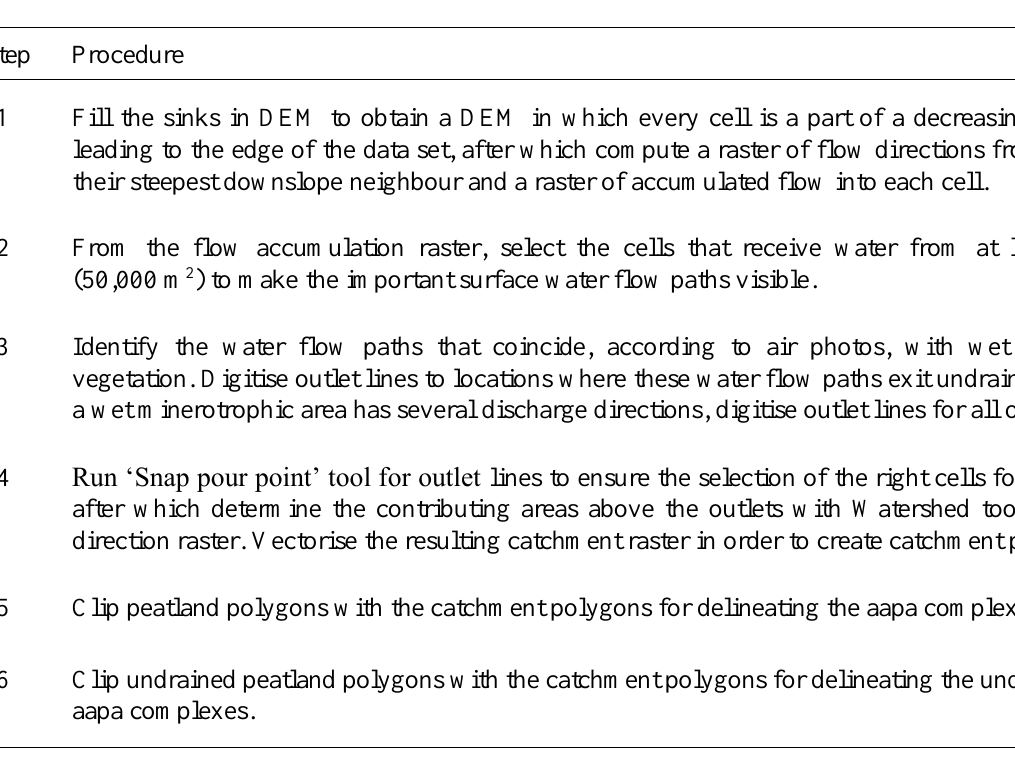
Table 2. Delineation of aapa mire complexes and their catchments in ArcGIS